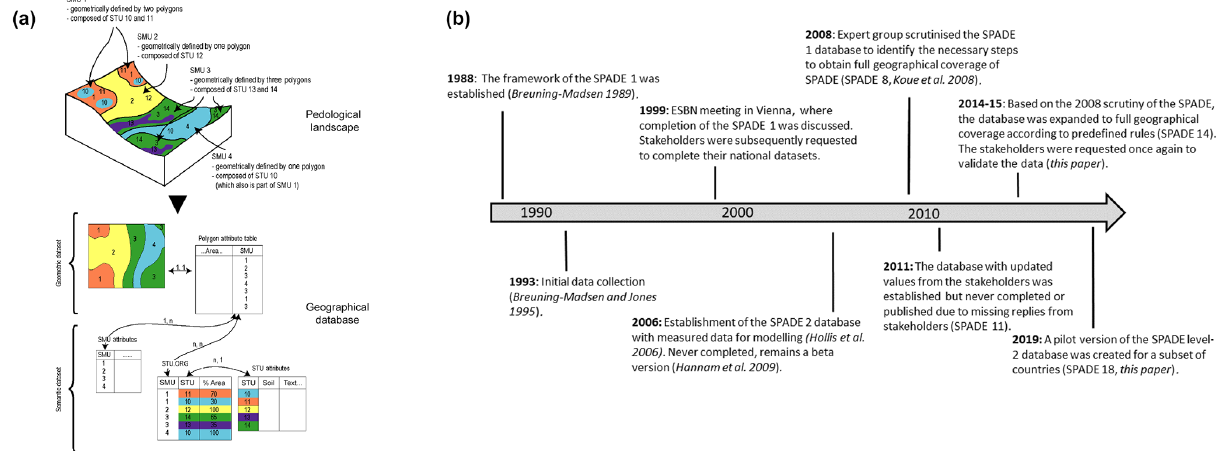
Figure 1. (a) Structure of the European Soil Database to which SPADE provides data (after Lambert et al., 2003). (b) Timeline of the establishment of the soil profile analytical database for Europe (SPADE). See text for